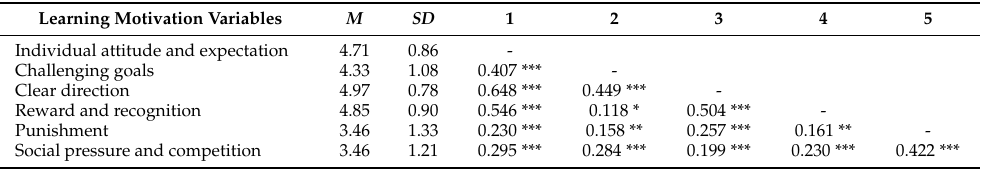
Table 6. The Learning Motivating Factors Questionnaire: descriptive statistics and correlations between the subscales.